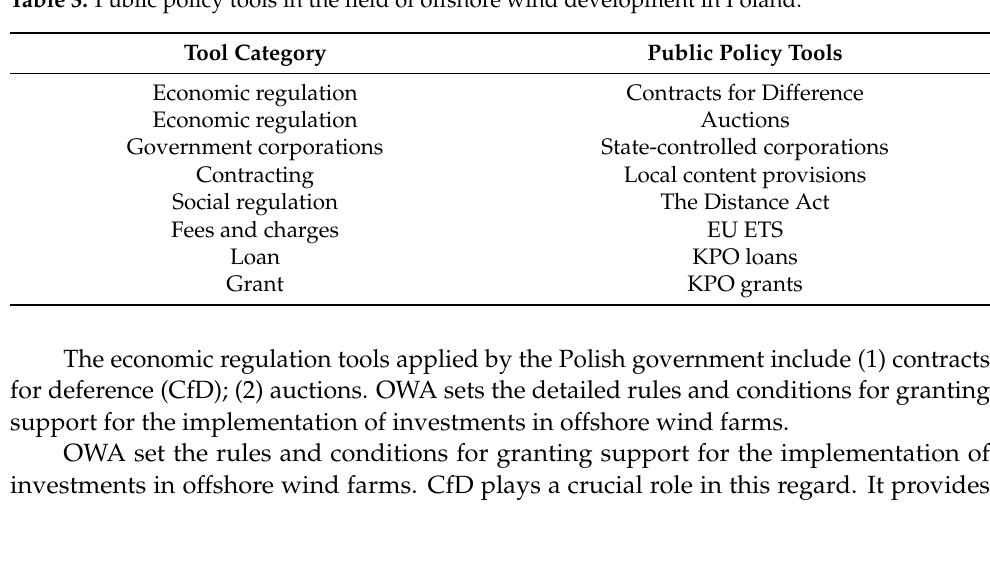
Table 3. Public policy tools in the field of offshore wind development in